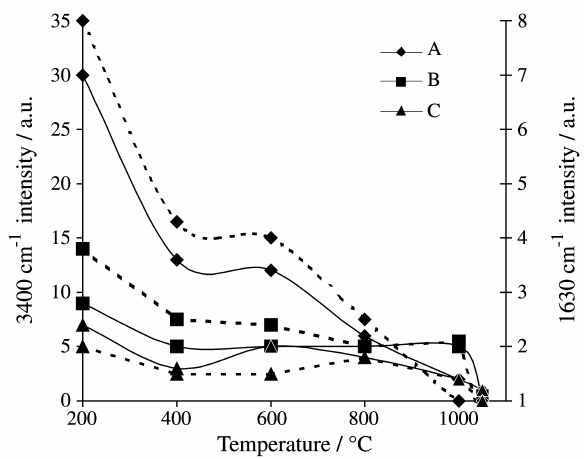
Figure 2. Variation of the normalized intensity of the 3400 cm -1 band ( ___ ) and 1630 cm -1 band (----), showed in Fig. 1, as a function of temperature. The lines were drawn only as guide for the